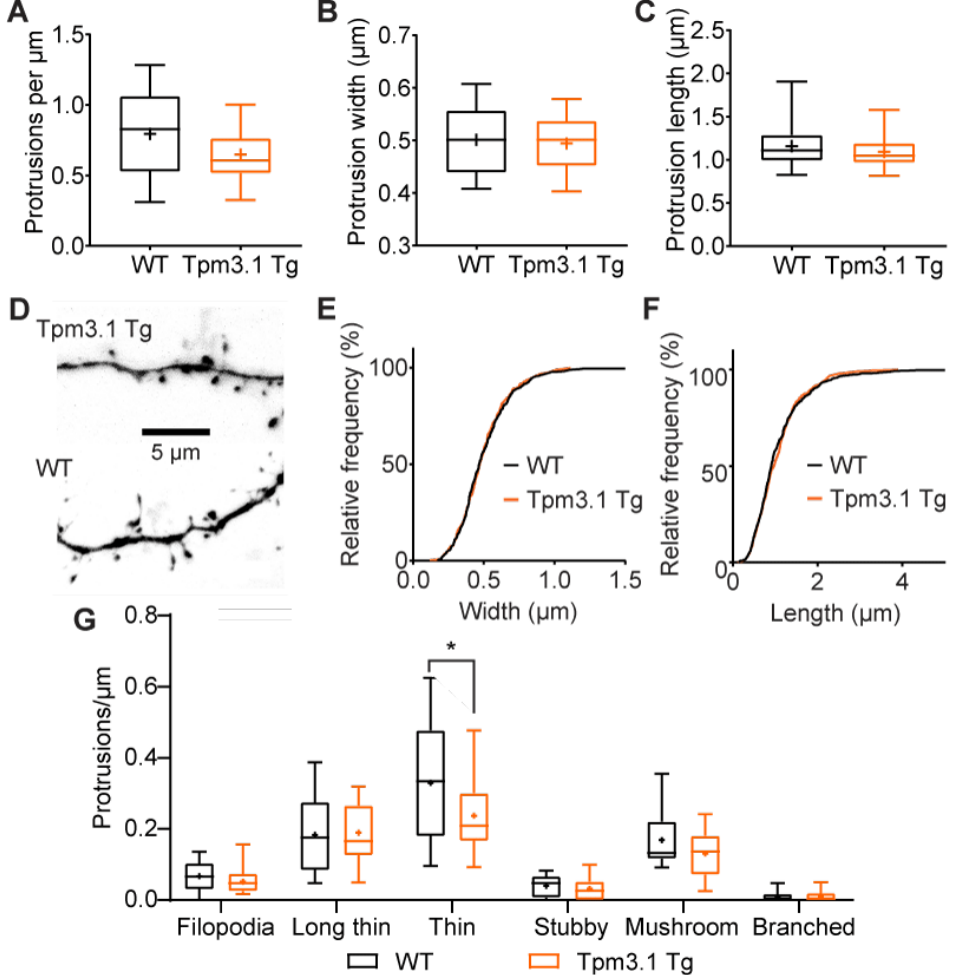
Figure 4. Overexpression of Tpm3.1 does not significantly alter dendritic spine morphology com- pared to WT. ( A ) Number of protrusions from the dendrite per μm was not significantly altered from control. ( B ) There was no observed difference in protrusion width or ( C ) average protrusion length. ( D ) Inverted representative images of dendritic segments, flattened from Z-stack. ( E , F ) Cu- mulative probability histograms of protrusion width and length showed no significant differences.